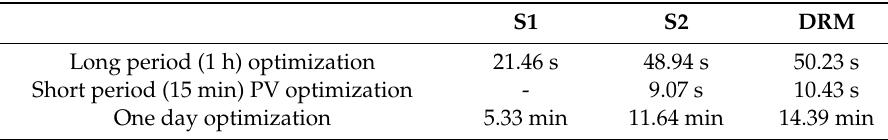
Table 7. Computation time of three